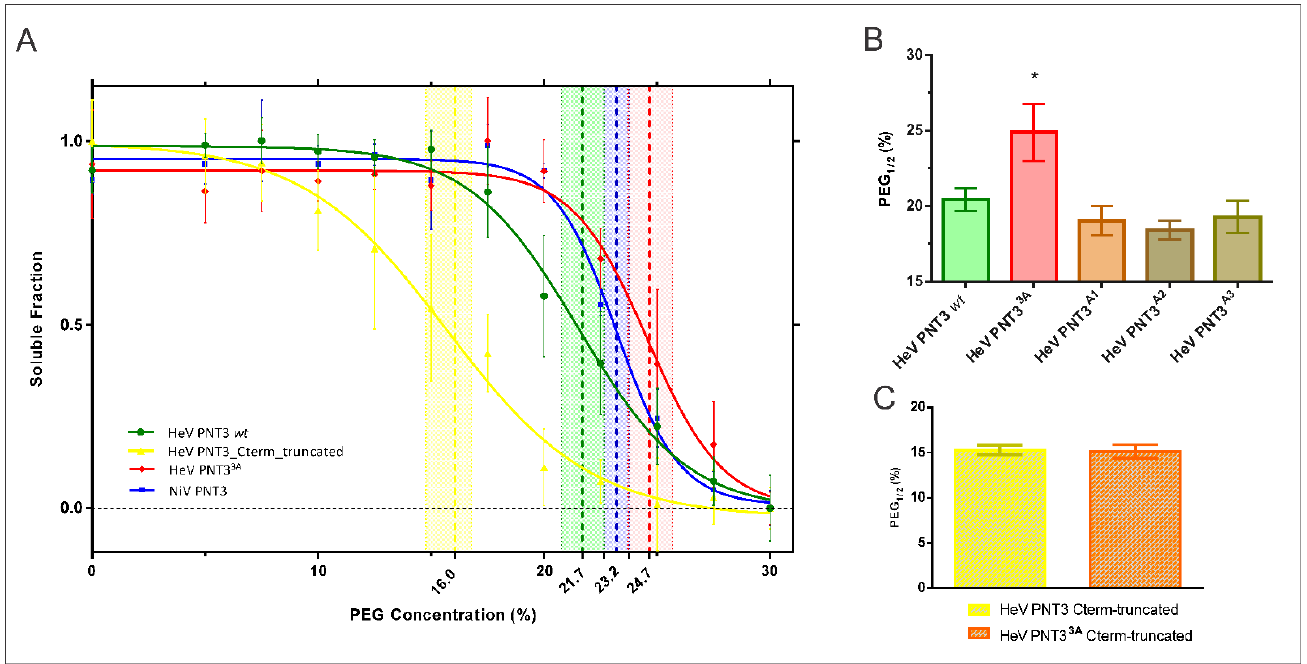
Figure 4. PEG solubility assays for the set of PNT3 variants. ( A ) Soluble fraction of each variant at different PEG concentrations. HeV PNT3 wt (green), HeV PNT3 3A (red), HeV PNT3_C-term_truncated (yellow), NiV PNT3 (blue). Vertical lines represent PEG 1/2 values including their 95% confidence intervals obtained after a normalization and fitting step to a sigmoid function. ( B ) PEG 1/2 values obtained for the wt , the triple alanine variant and the single alanine HeV PNT3 variants. ( C ) PEG 1/2 values obtained for the C-terminally truncated variants. The asterisk indicates statistically significant differences (One-way Anova test, p -value < 0.05).